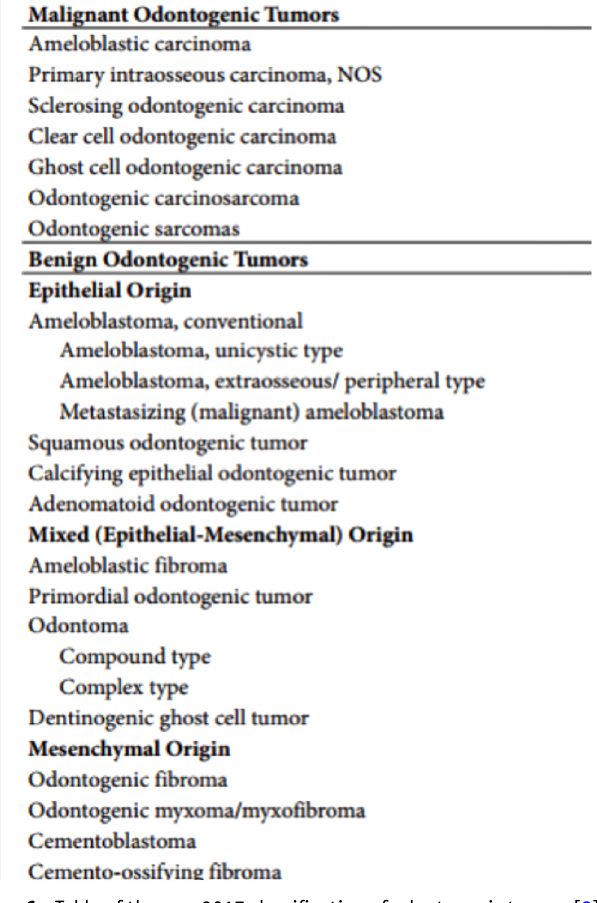
Fig. 6. Table of the new 2017 classi fi cation of odontogenic tumors